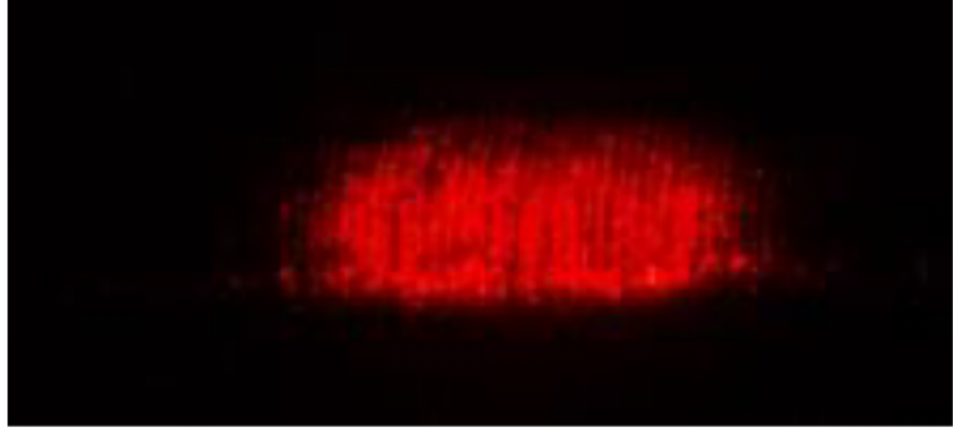
Figure 4. Laser speckle